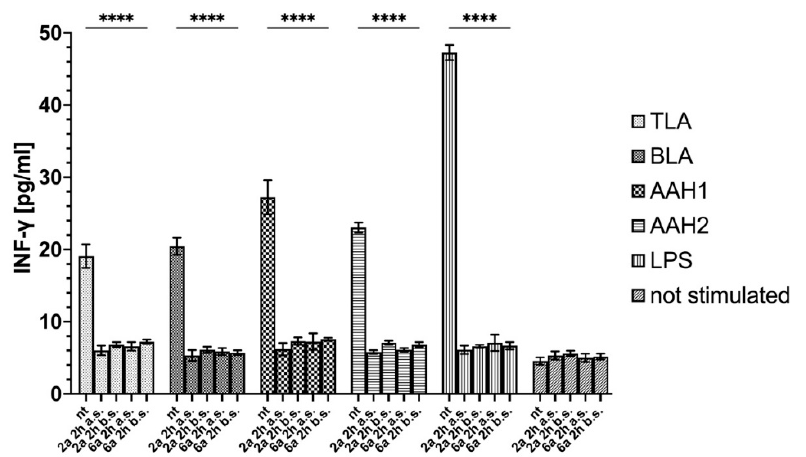
Figure 7. INF- γ production from supernatants after human monocytes were exposed to TLA, BLA, AAH1, or AAH2, or treated with LPS (positive control). Data are shown as the means from three repeats with error bars that indicate the standard deviations. Data were compared using a two-way ANOVA test, and for significant comparisons, further analysis was performed using Dunnett’s multiple comparisons test. Values with statistically significant differences are labeled by asterisks; **** p < 0.0001. The differences were considered significant when p values were less than 0.05, and such differences are presented in Supplementary Materials Table S1. Aberration: nt—not treated; a.s. af-